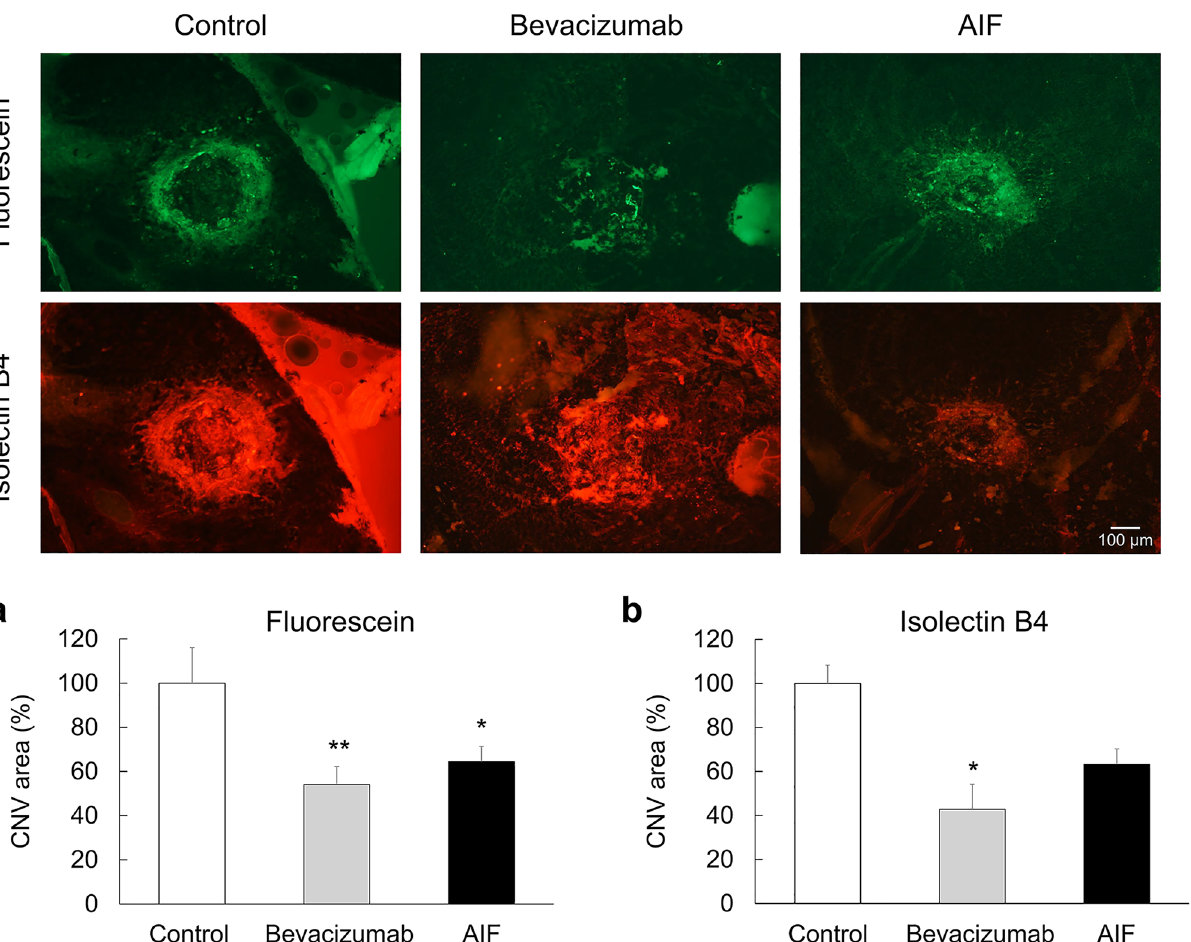
Figure 4. Effects of alpinumisoflavone (AIF) on laser-induced mouse model on choroidal neovascularisation (CNV) area. AIF suppresses the development of the CNV area in the laser-induced CNV mouse model. Representative images of CNV lesions and quantification of its area and volume in mice eyes that underwent laser photocoagulation administered with bevacizumab or AIF (Both 1 μL, 25 μg, intravitreal injection). One week later, the CNV area was analysed via measurement of fluorescence intensity of images with ( a ) fluorescein and ( b ) isolectin B4 positive area. Data were analysed using one-way ANOVA followed by the Holm-Šídák post- hoc t-test (* p < 0.05 and ** p < 0.01 vs. control group). The results are expressed as mean ± S.E. (n = 7–9). The scale bar in each image is 100